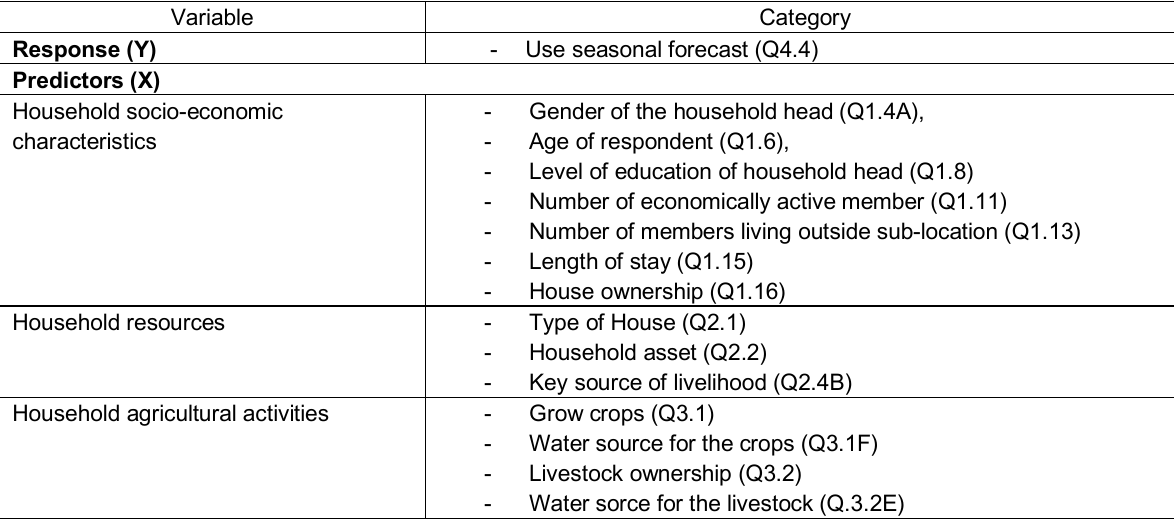
Table 1: Variables used in this